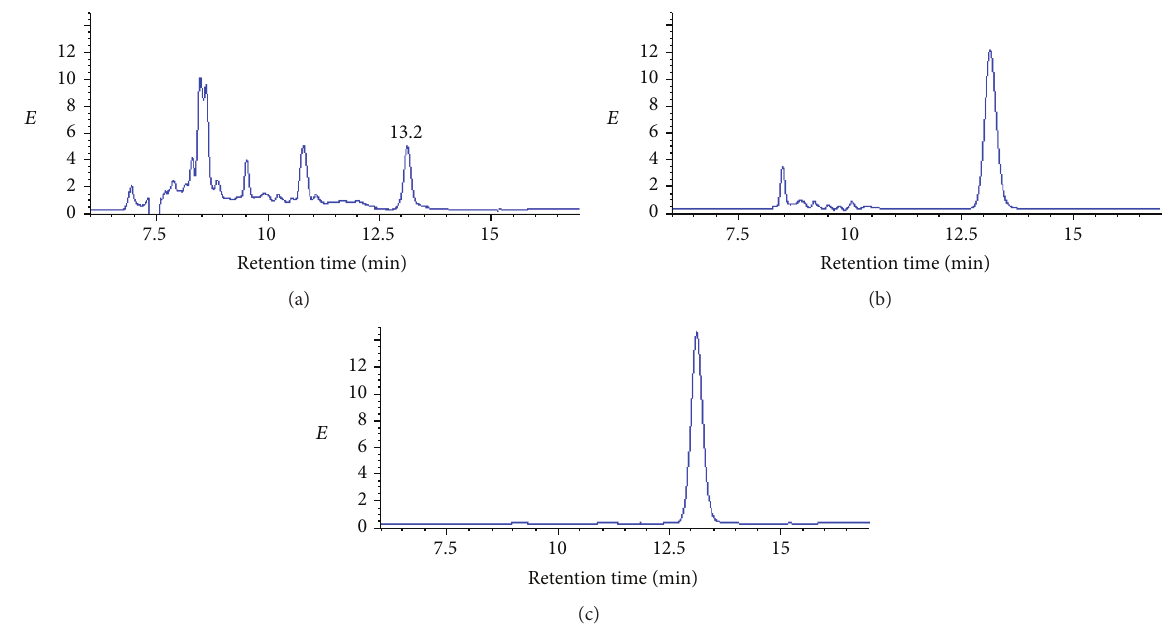
Figure 4: The chromatograms obtained by the spiked milk samples (100 ng ⋅ mL −1 ) with C18 SPE (a), extraction with MSPE (b), and standard solution (c).